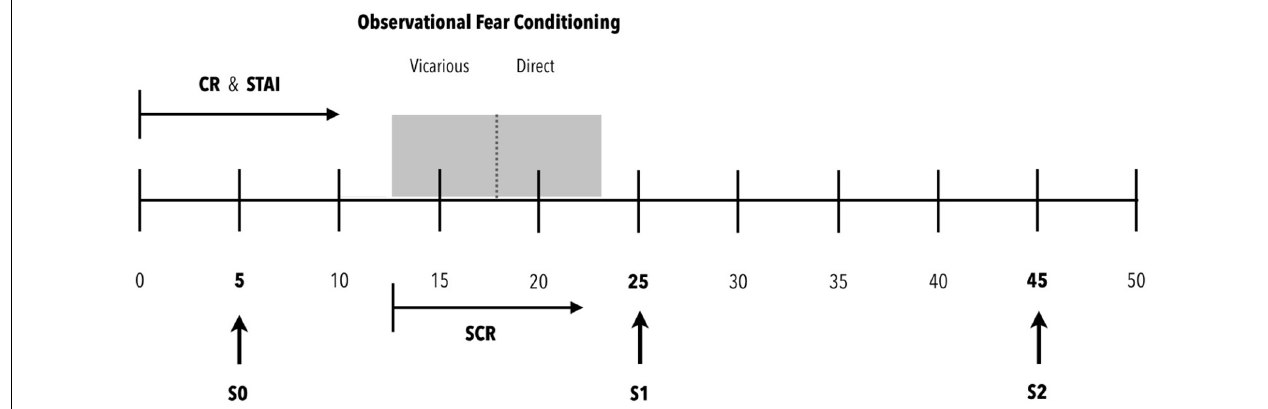
FIGURE 1 | Procedure. Participants arrive at the experimental room (0 min). They are provided with the Cognitive Reserve (CR) and State-Trait Anxiety (STAI) scales for completion. Within 5 min of arriving in the experimental room, the first saliva sample (S0) is requested to establish the baseline cortisol concentration. Ten minutes after arriving in the experimental room, once the scales have been completed, the observational fear conditioning protocol is initiated. For this purpose, the electrodes for recording the electrical conductance of the skin are placed and the appropriate checks are made to ensure a correct recording of the signal. After these actions, the observational fear conditioning protocol is initiated. This protocol consists of two phases: vicarious and direct. During both phases, the electrical skin conductance (SCR) is recorded. At the end of the protocol, the skin conductance recording session is saved, and the electrodes are removed from the participant’s hand. After this, the second saliva sample (S1) is obtained. This sample expects to be able to detect peak cortisol concentrations from the beginning of the evaluation protocol (0 min). After 20 min of rest, the third saliva sample (S2) is obtained to evaluate a possible recovery toward basal cortisol